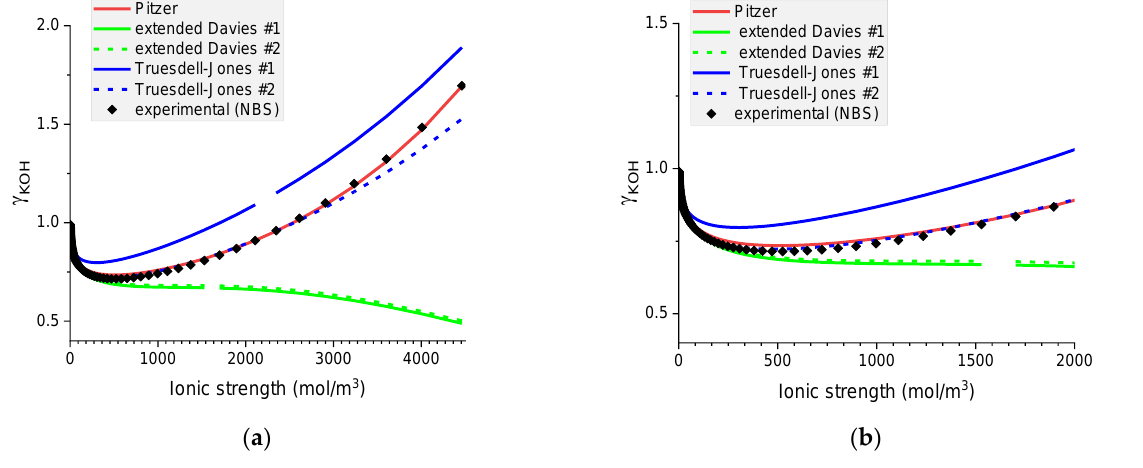
Figure 4. Molar mean ionic activity coefficients in aqueous KOH for ( a ) concentrated and ( b ) dilute solutions. Comparison of calculated activity coefficients based on the Pitzer, extended Davies, and Truesdell – Jones models with experimental results (NBS) at 25 °C.